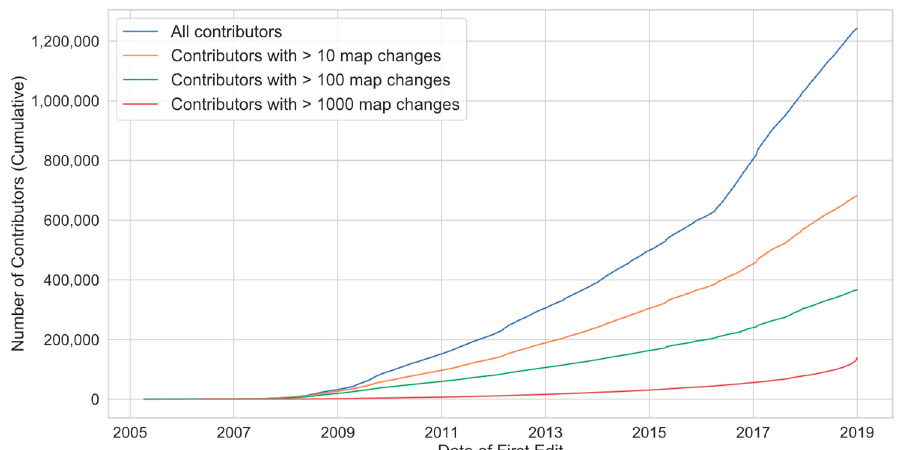
Figure 1. OpenStreetMap Contributors: Over 1 million users have made at least 1 change to the map. Far fewer contributors have contributed more than 10, 100, or 1000 times. Results calculated from an OSM changeset database, created from the OSM changeset files by the open source tool: github.com/toebee/changesetmd.